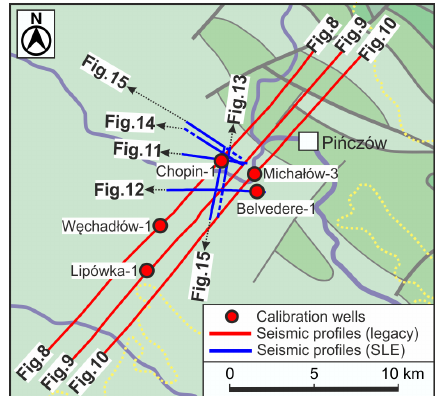
Figure 5. Detailed view of the study area with the location of wells and seismic data. Solid lines (red and blue) mark the sections of the seismic profiles shown in Figs. 8–15. Background geological map (based on Dadlez et al., 2000; ˙Zytko et al., 1988; simplified) from Fig. 3 (see for